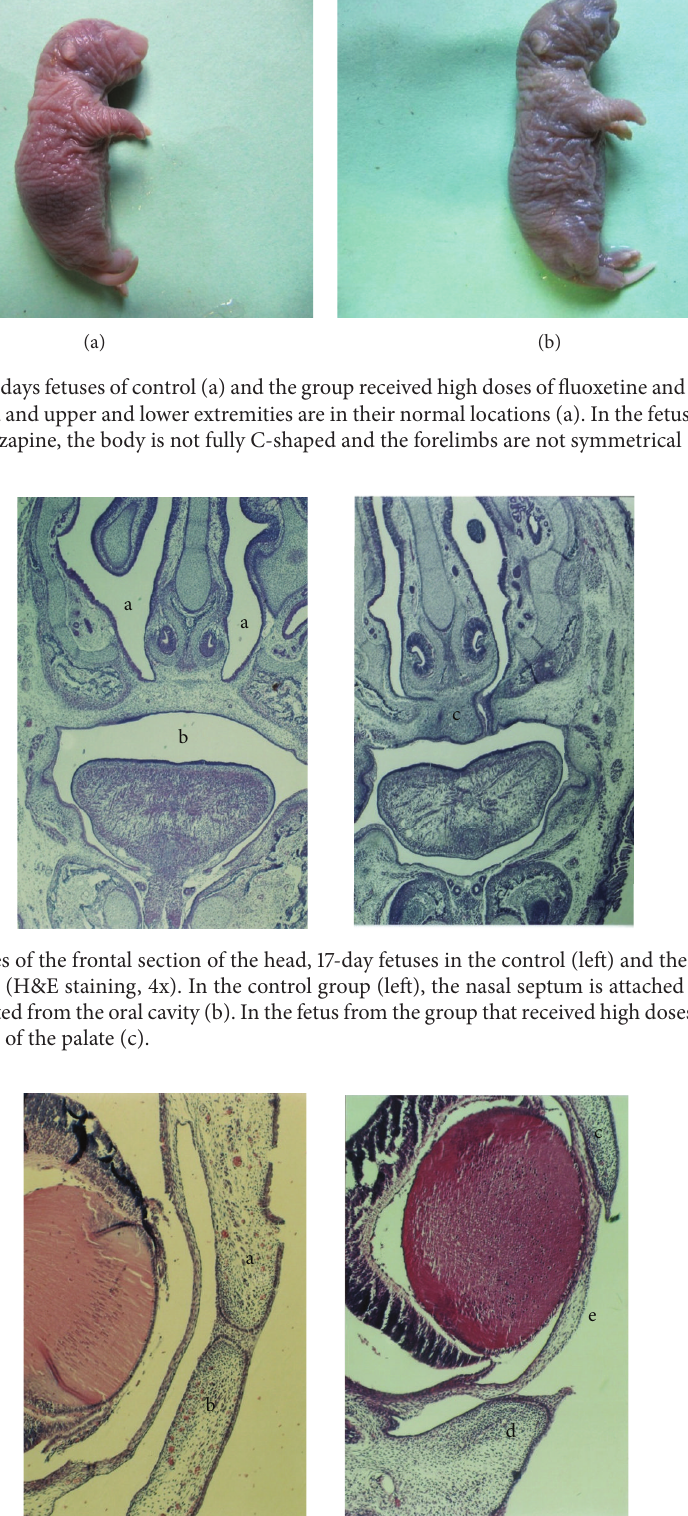
Figure 3: Histopathological slides of the eyes from 17 days fetuses in control (left) and the group received high doses of fluoxetine and olanzapine (right) (H&E staining, 10x). In control group fetus (left), the upper (a) and lower (b) eyelids are joined completely. In the fetus from the group that received high doses of fluoxetine and olanzapine (right), the upper (c) and lower (d) eyelids were separated completely and the cornea (e) is